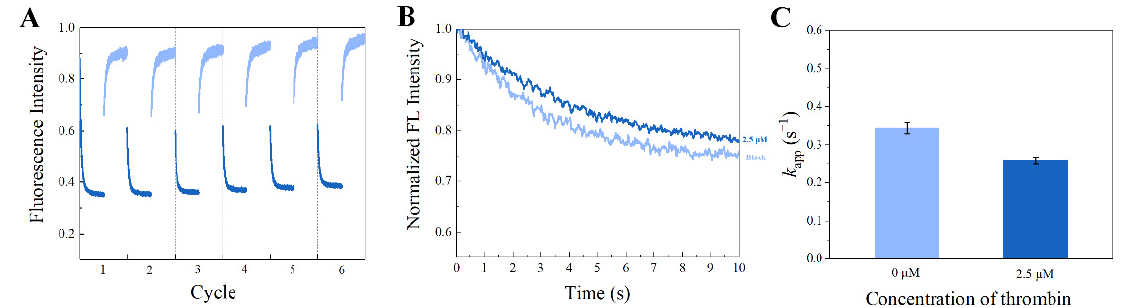
Figure 9. Regenerating of the SITS-Thrombin27 5 (cid:48) aptasensor. ( A ) SITS-Thrombin27 5 (cid:48) excited at ex/em = 333 nm/426 nm ( trans – cis ) for 60 s followed by ex/em = 280 nm/426 mm ( cis – trans ) for 60 s for six cycles as an illustration. ( B ) The fluorescence attenuation curves and ( C ) the k app values of the SITS-thrombin27 5 (cid:48) after six illustration cycles in the presence and absence of